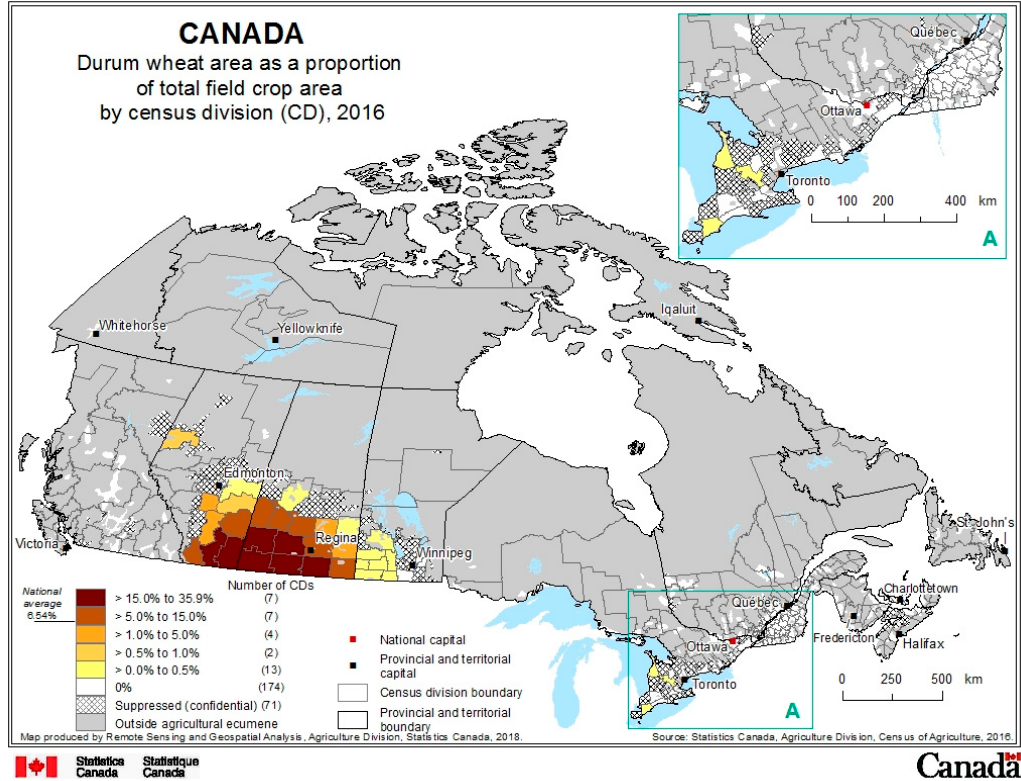
Figure 2. The majority of the Canadian durum wheat-growing areas [6].